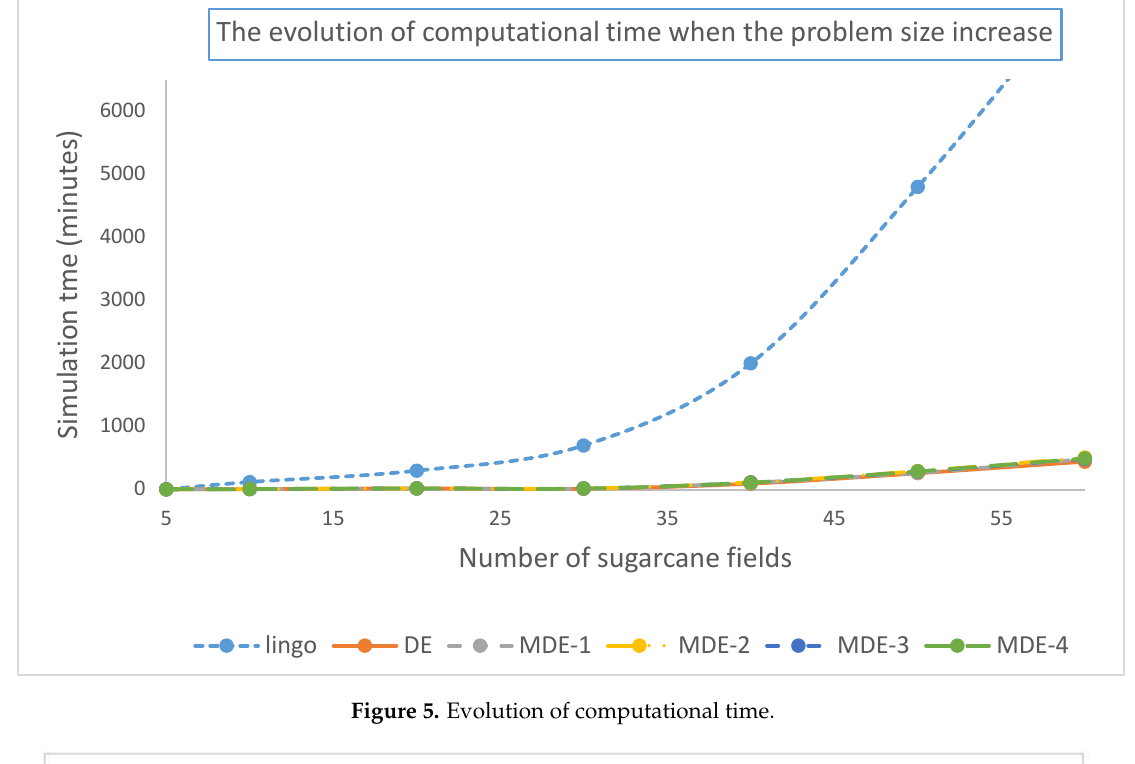
Figure 6. Evolution of the proposed heuristics. Figure 5. Evolution of computational time. Figure 5. Evolution of computational time.